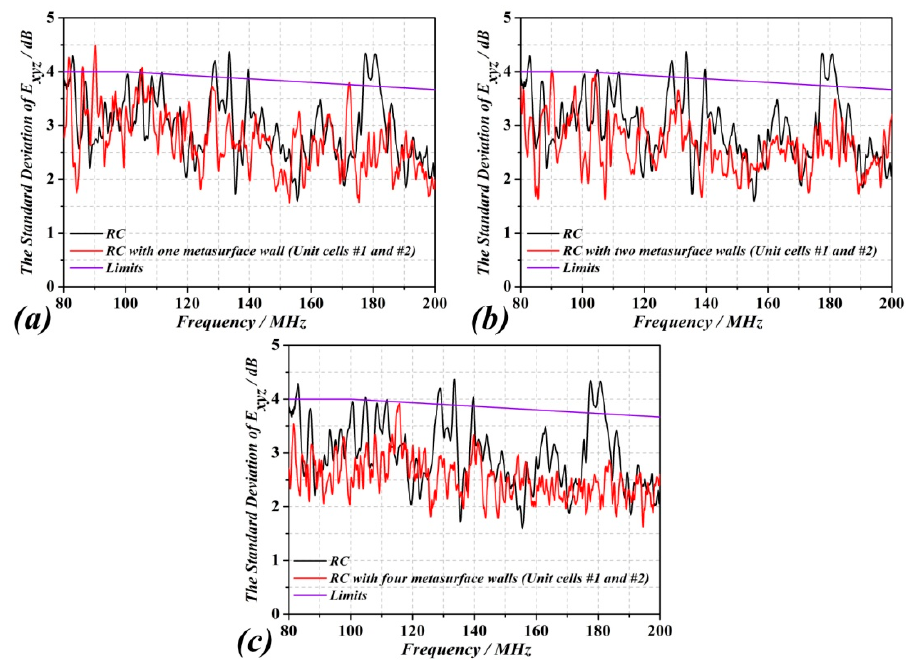
Figure 8. Standard deviations of the field strengths in the RC without metasurface compared to the RC with different numbers of metasurface walls. The purple lines are the tolerance requirements for the standard deviation of Ref. [10]; ( a ) Field uniformity of the combination of xyz components in the RC with one metasurface wall, ( b ) with two metasurface walls, ( c ) with four metasurface walls.